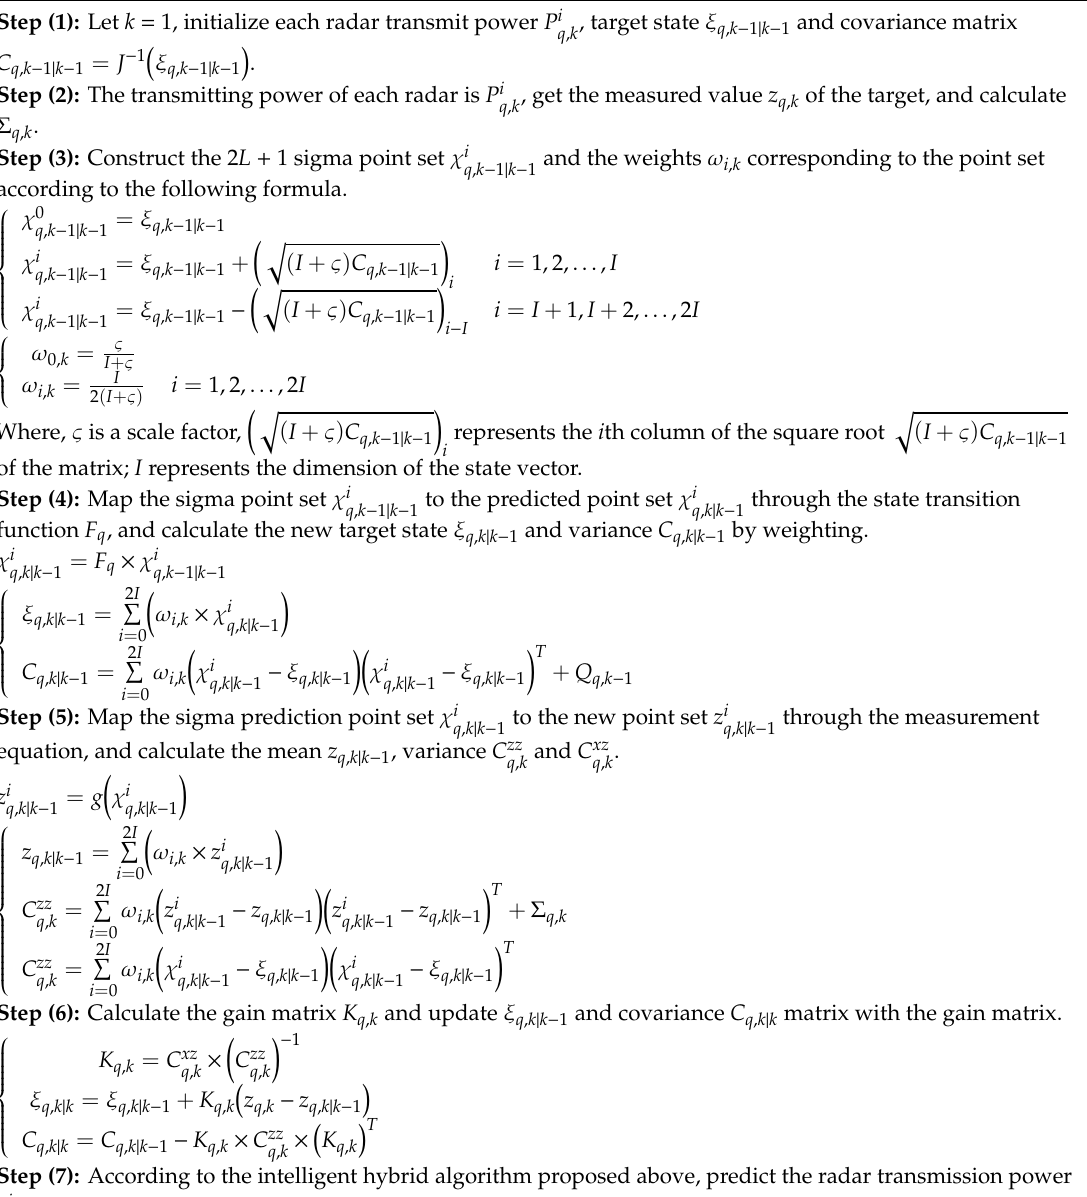
Algorithm 3. UKF